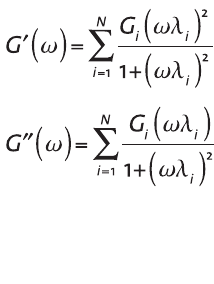
Figure 8 (left): a) Storage modulus, G’, loss modulus, G’’, complex vis- cosity, h *, and b) loss tangent,tan d , as a function of angular fre- quency, w , for PDMS mea- sured on the parallel plate rheometer (filled symbols) and HF-SPR (unfilled sym- bols). Solid lines are the gen- eralized Maxwell model extrapolated to 210 Hz. Figure 9: Complex viscosity data as a function of frequency for PDMS measured on the par- allel plate rheometer (filled symbols) and the HF-SPR (unfilled symbols). Solid line is the Cross model extrapo- lated to 210 Hz. Table 1: Discrete relaxation spec- trum for